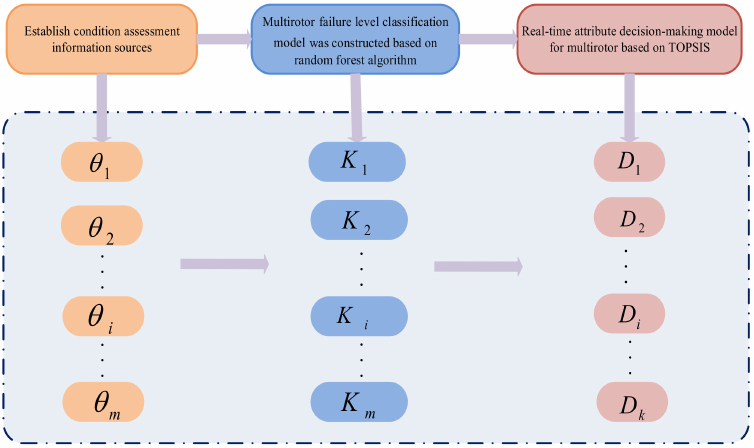
Figure 1. Algorithm flow